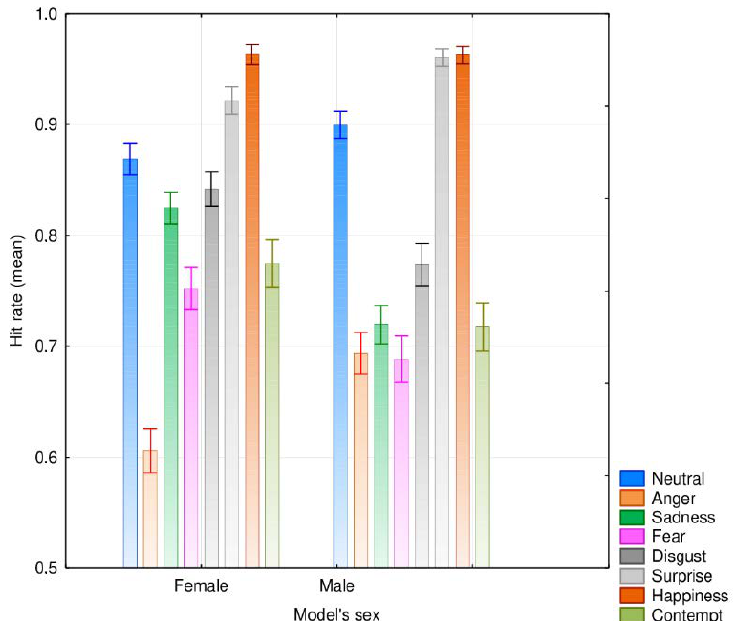
Figure 4. Mean agreement rates for the different emotional categories depending on the models’ sex (error bars represent 95% CI).